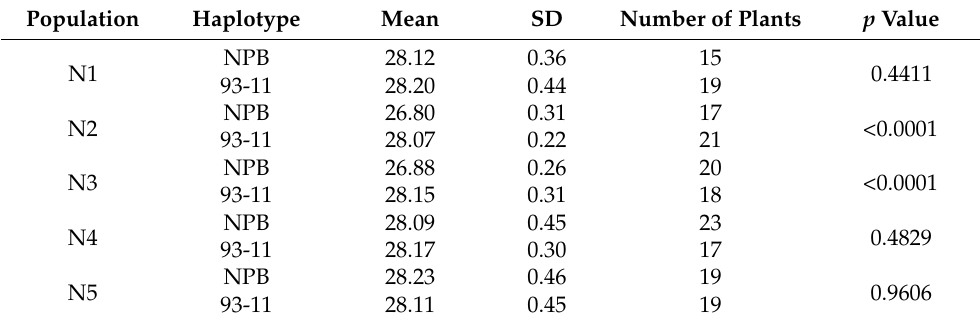
Table 6. Phenotypic analysis of TGW of NPB and 93-11 homozygotes in five recombinant population in BC 9 F 5 .